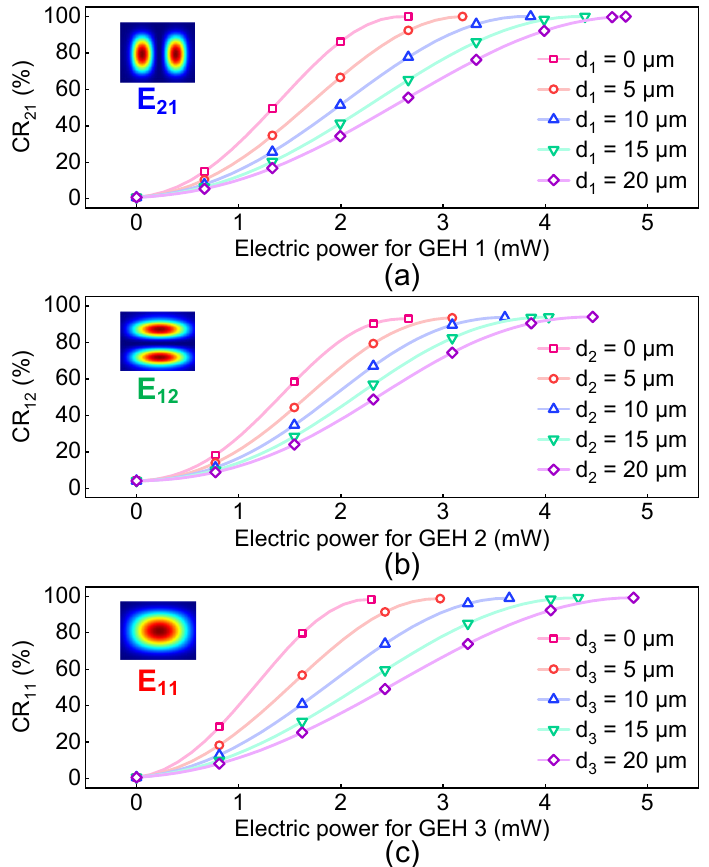
Figure 6. The CRs of ( a ) the E 21, ( b ) the E 12 and ( c ) the E 11 modes with the electric power for different core-graphene distances.